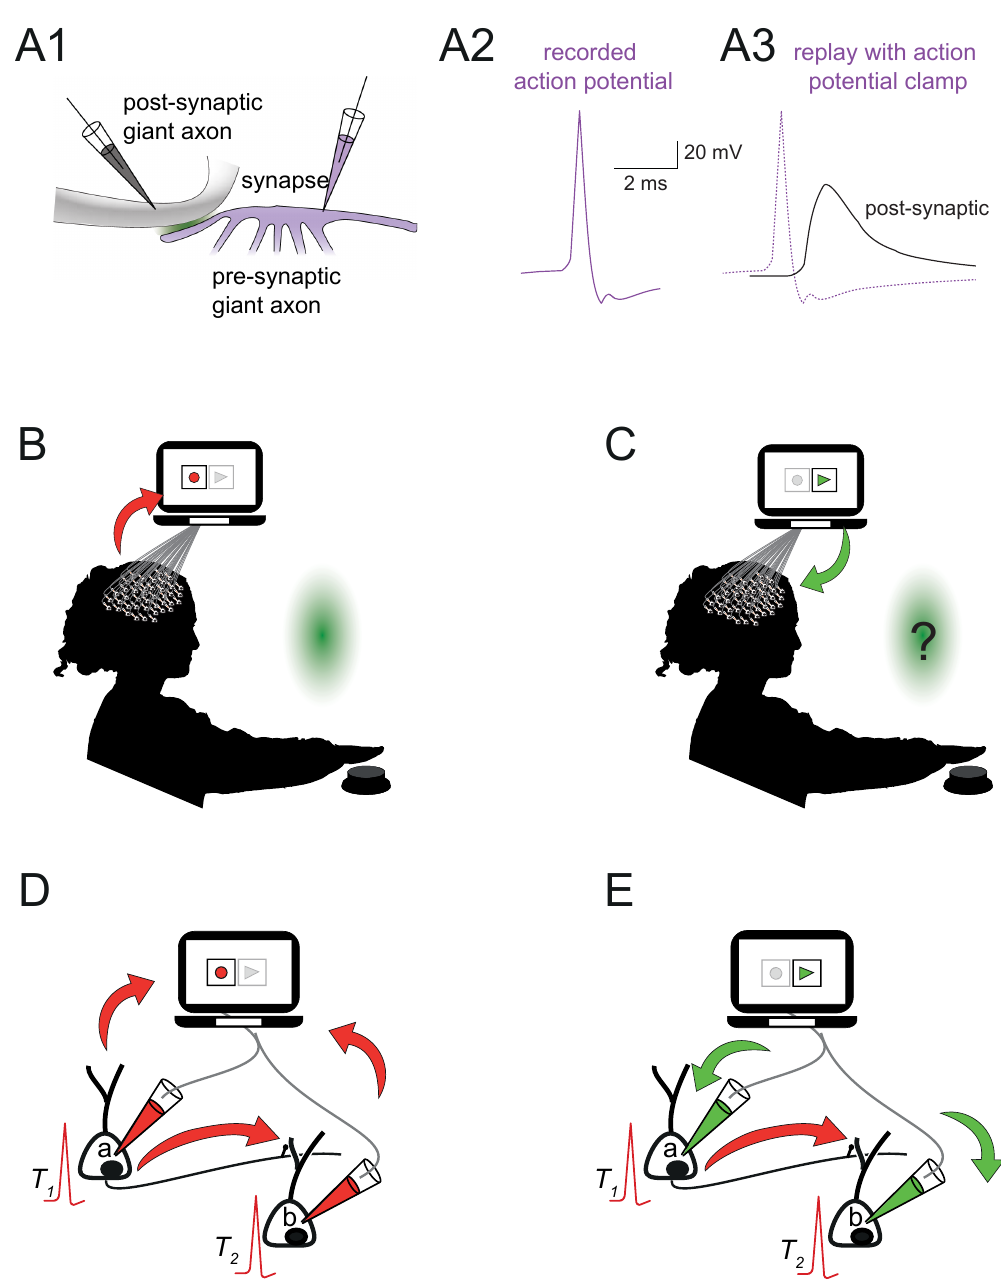
Fig 1. Recording and replaying action potentials in the entire brain. (A1) Experimental schematic of the action potential replay in the squid giant synapse as done in [41]. (A2) Action potential recorded from the presynaptic terminal (solid purple line) is set as the “command” voltage. (A3) The action potential recorded in A2 (i.e., the command voltage) is replayed (dotted purple line), and the postsynaptic response was “virtually indistinguishable from that obtained with the original presynaptic spike activation” [42]. (B) A stimulus (green light on a screen) is presented to the participant while all action potentials from each neuron in the brain are recorded and stored for later retrieval. The participant is asked to press a button when she consciously perceives the green light. (C) Step 1: All patterns of the action potential are played back into each neuron using the voltage clamp. The participant presses a button during the replay because the relevant motor neurons are activated. (D) Activity in 2 representative neurons from the participant’s brain; during the recording, neuron a fires at time T 1 and causes action potential in neuron b at time T 2 . Red arrows indicate the direction of cause and effect between the neurons and the controller; Neuron a causes action potential in neuron b , and both are recorded by the controller. E . During replay, neuron a and neuron b fire exactly at times T 1 and T 2 , respectively, as in C, but both action potentials are caused by the replay controller (depicted by the green arrows). In both C and D, the action potentials propagate through the axon (depicted by the red arrow), but in D, they do not affect the firing of neuron b